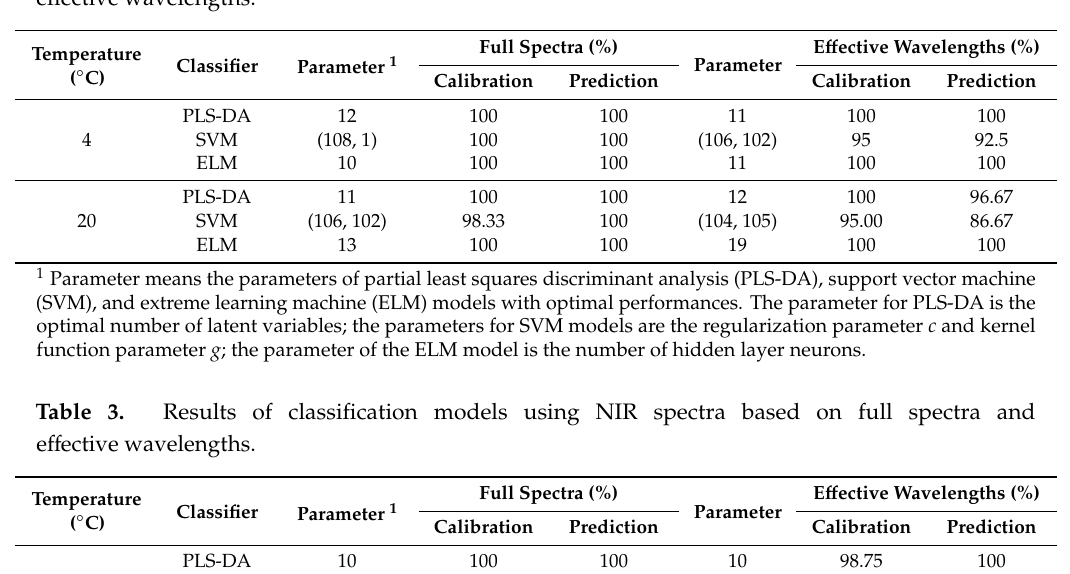
Table 2. Results of classification models using Vis-NIR spectra based on full spectra and e ff ective wavelengths.